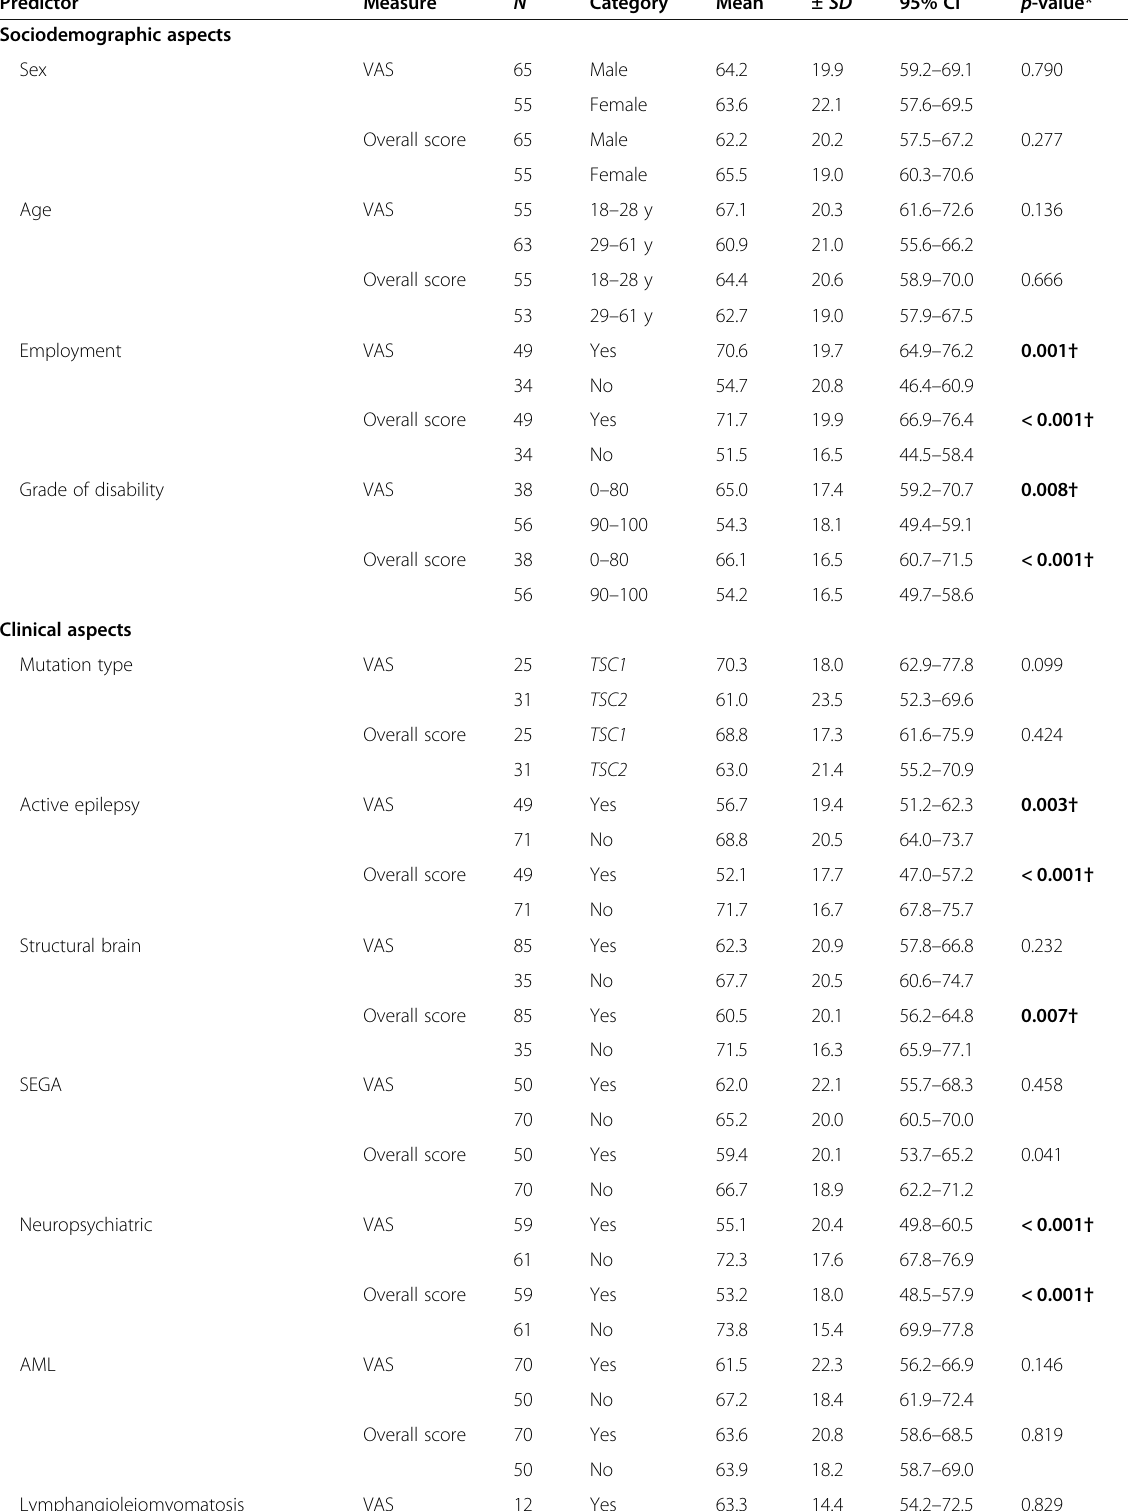
Table 3 Comparisons of health-related quality of life among individuals with TSC, as measured by the QOLIE-31 (German version) questionnaire, according to several potential predictors and assessed using the Kruskal – Wallis and Chi-square tests